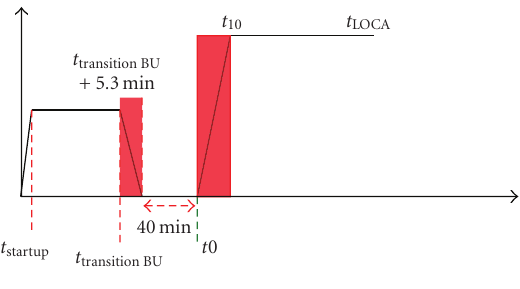
Figure 4: Timing of refueling.